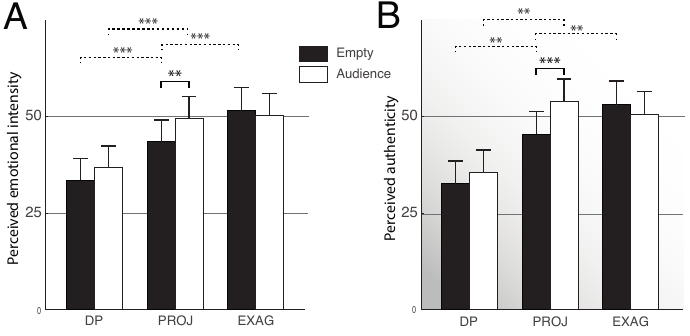
Figure 3. Interaction of the expressiveness and the presence of an audience on: ( A ) the perceived emotional intensity; and ( B ) the perceived authenticity (deadpan: DP, projected: PROJ, and exaggerated: EXAG) (** p < 0.01, *** p <